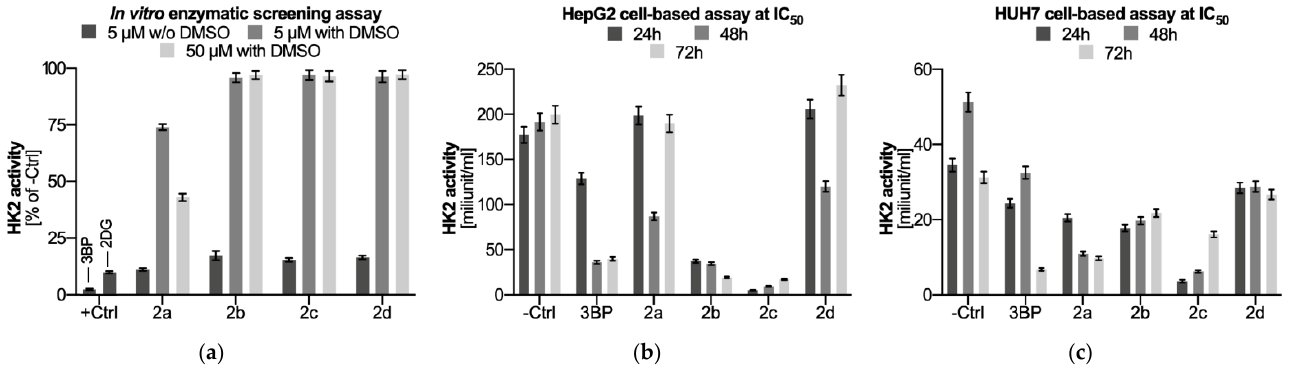
Figure 2. ( a ) In vitro enzyme inhibition assay results. 3BP (2.5 ± 0.4%) and 2DG (9.9 ± 0.5%) are positive controls (+Ctrl), both compounds were used at 5 μ M. The negative control is the corresponding assay system without inhibitor, whose activity is assumed to be 100%. 3BP and 2DG samples were prepared in assay buffer containing 0.1% Tween 20. Changes in HK2 activity in ( b ) HepG2 and ( c ) HUH7 cell lines after 24 h, 48 h and 72 h incubation with the test compounds at IC 50 concentrations. 3BP at 100 μ M was used as a positive control. Data are presented as milliunits of enzyme activity per milliliter of reaction mixture. Data are presented as mean and SD, n = 3. The significance of differences was estimated based on multifactor ANOVA and post-hoc Tukey tests. Statistical analysis for cellular assay: HepG2+2a: p < 0.05: control vs. IC 50 48 h; HepG2+2b: p < 0.001: control vs. IC 50 24 h, IC 50 48 h and IC 50 72 h; HepG2+2c: p < 0.001: control vs. IC 50 24 h, IC 50 48 h and IC 50 72 h; HepG2+2d: p < 0.01: control vs. IC 50 48 h; HUH7+2a: p < 0.05: control vs. IC 50 24 h; p < 0.001 control vs. IC 50 48 h and IC 50 72 h; HUH7+2b: p < 0.01: control vs. IC 50 48 h; p < 0.001 control vs. IC 50 24 h and IC 50 72 h; HUH7+2c: p < 0.05: control vs. IC 50 72 h; p < 0.001 control vs. IC 50 24 h and IC 50 48 h; HUH7+2d: p < 0.001 control vs. IC 50 48 h. For more experimental details please see “Materials and Methods”.